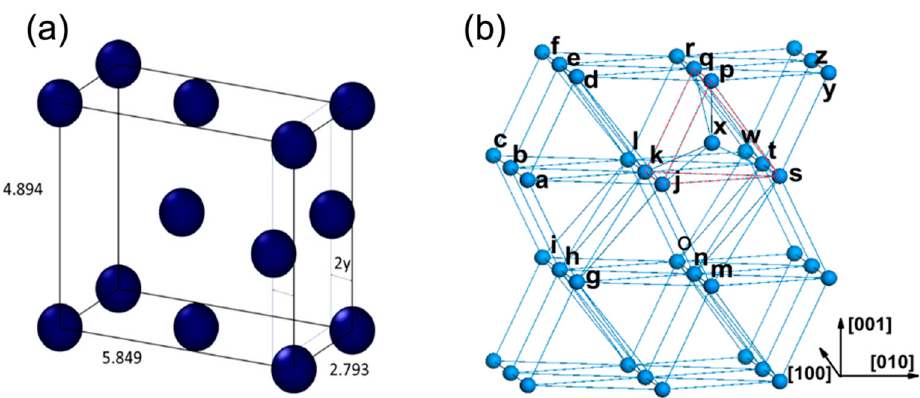
Figure 1. ( a ) α -U unit cell with lattice parameters estimated by Beeler (reprinted and adapted with permission from [7], 2022, Elsevier). ( b ) schematic structure of α -U and the most stable self-interstitial configuration (reprinted and adapted with permission from [8], 2022, IOP publishing, Ltd).